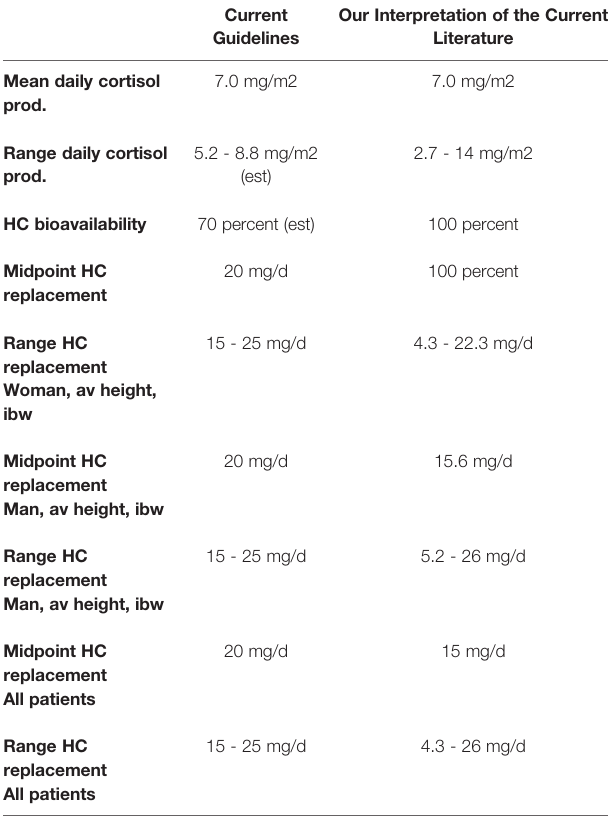
TABLE 1 | Comparison of Current Guidelines for treating adrenal insuf fi ciency with our interpretation of the current